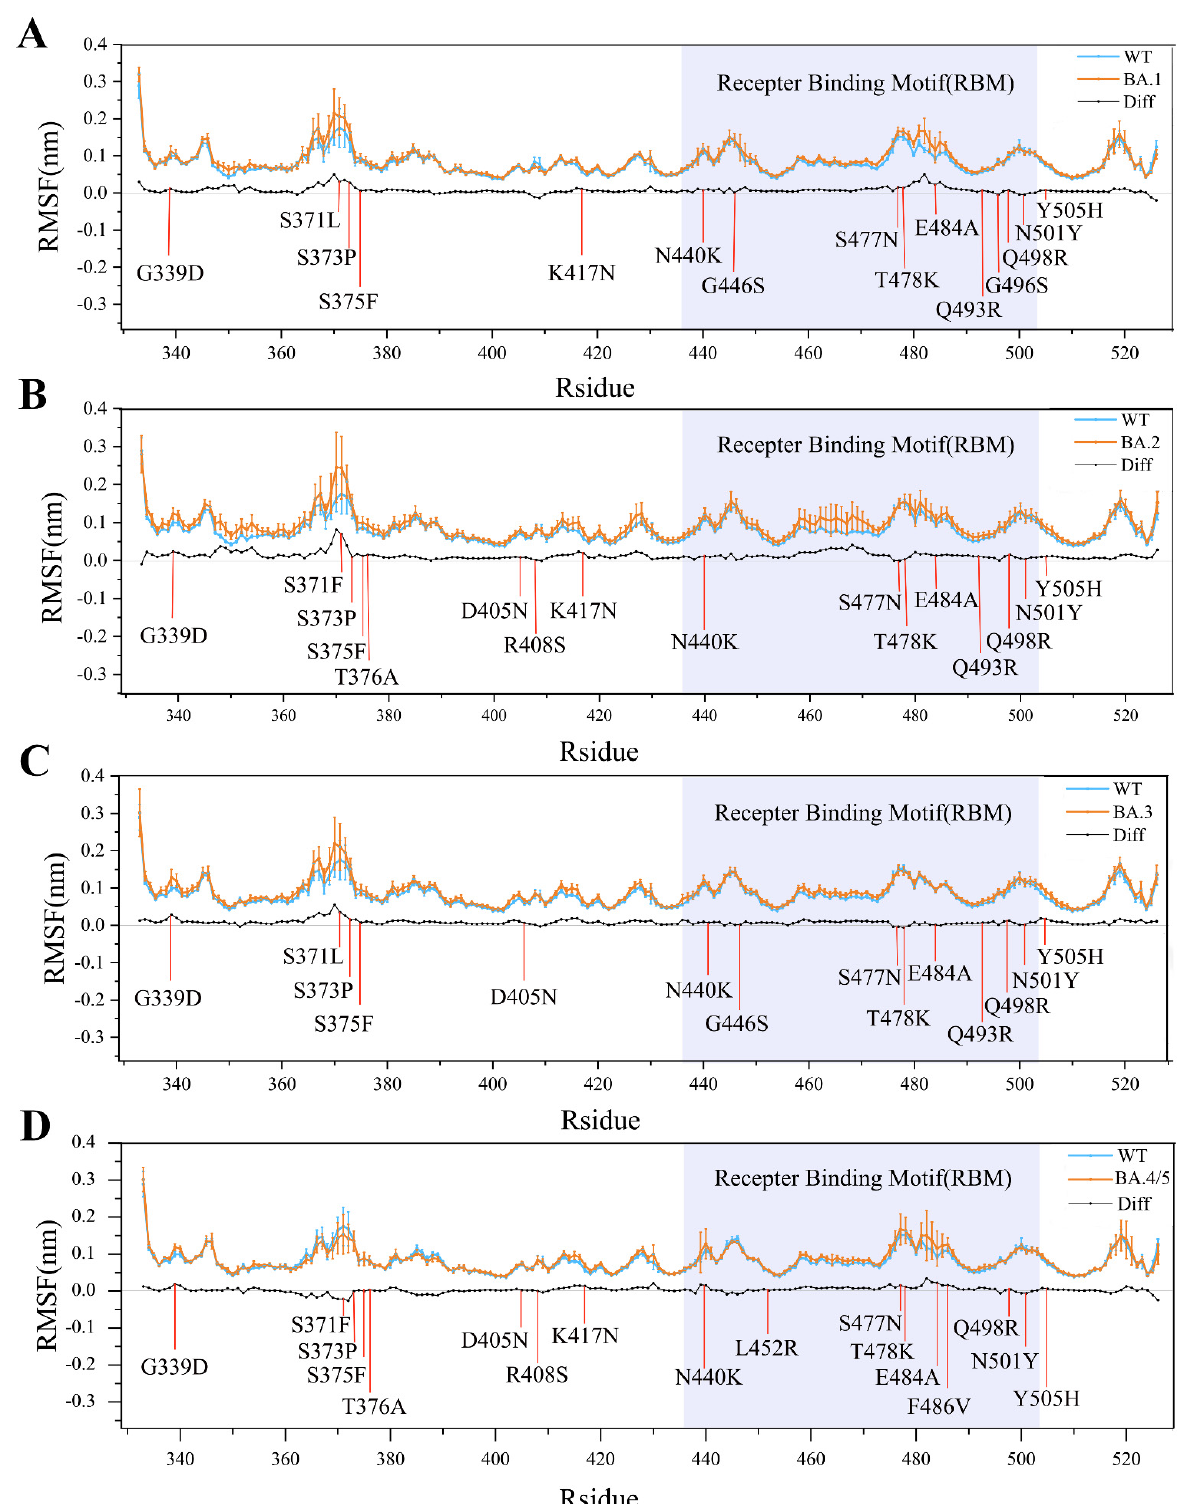
Figure 3. Comparison between the structural flexibility of RBD OMI s (orange line) and RBD WT (blue line). ( A ) RBD BA.1 and RBD WT . ( B ) RBD BA.2 and RBD WT . ( C ) RBD BA.3 and RBD WT . ( D ) RBD BA.4/5 and RBD WT . The flexibility is measured by per-residue RMSF values with error bars of different replicas. The mutations in RBD OMI s are highlighted in red. RMSF-difference (black line) was obtained by subtracting RBD WT RMSF values from RBD OMI s values. The RBM region is shaded in light blue.